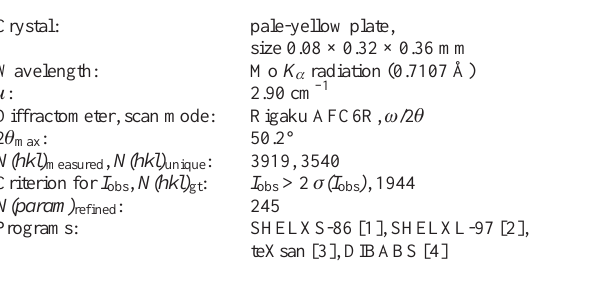
Table 1. Data collection and handling.